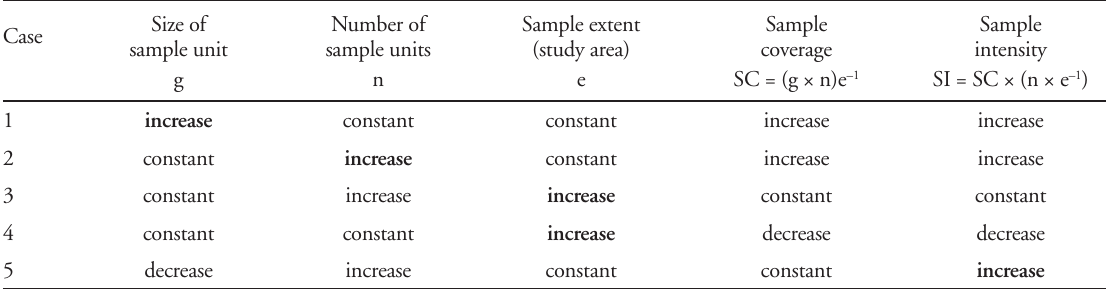
Table 1. The different cases of sampling protocol parameters influencing the shape of the occupancy distributions, that were separately investigated in this study. Bold font: target parameter changed; normal font: parameter hold constant or changing automatically with target parameter